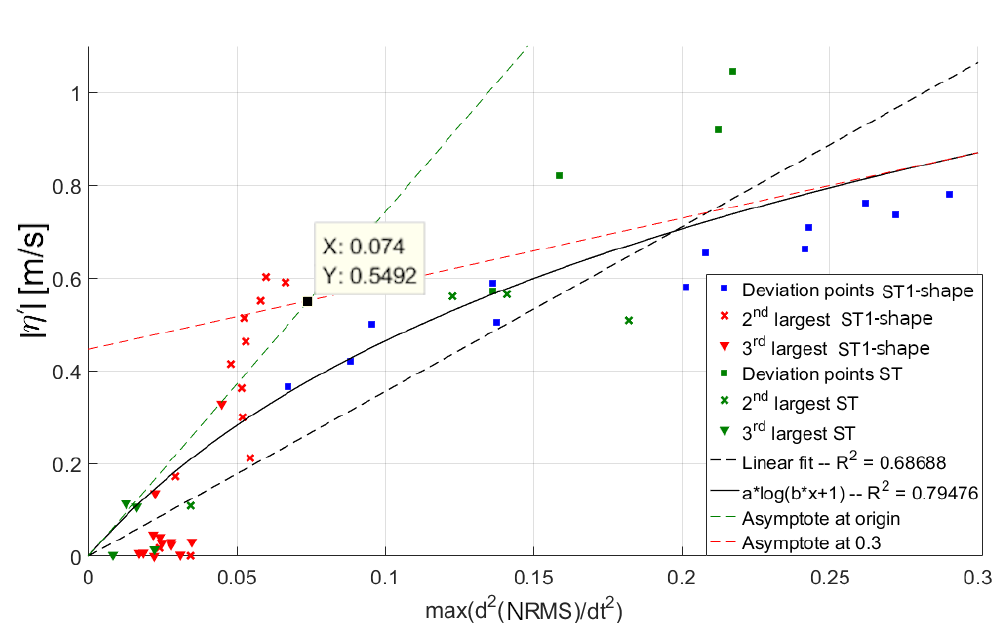
Figure 11. Evolution of | η (cid:48) | identified at deviation and non-deviating points for all